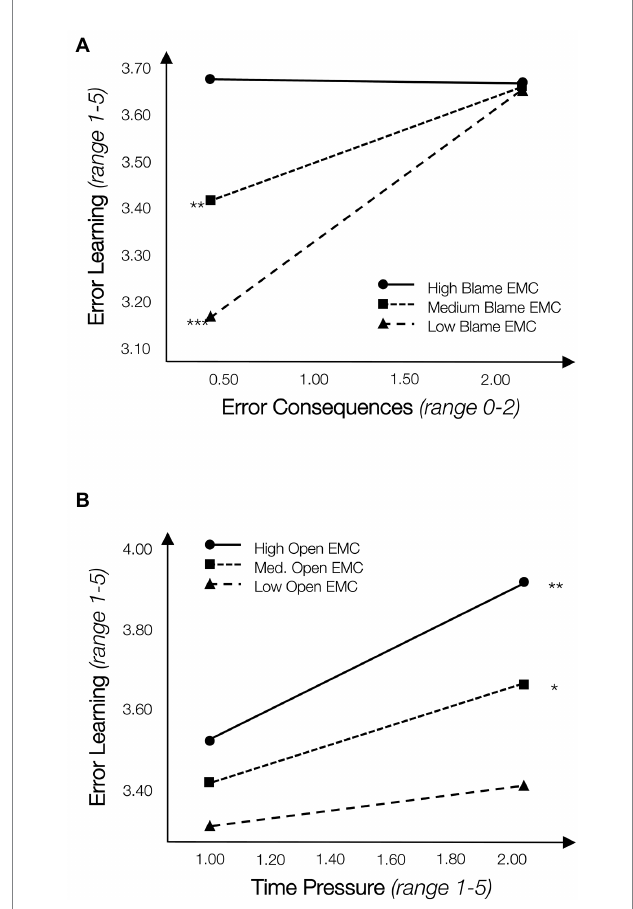
FIGURE 2 Moderating role of open and blame error management climate